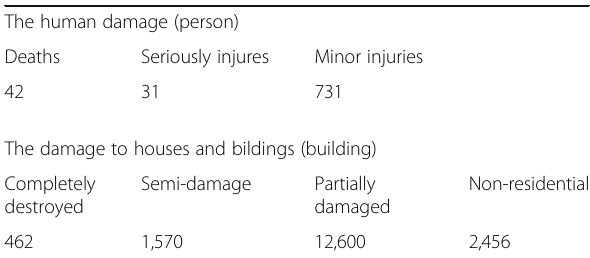
Table 1 (a) The Human damage caused by the earthquake. (b) The houses and buildings damage caused by the